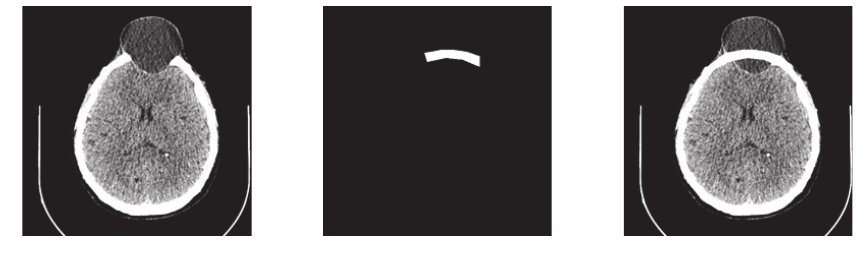
Figure 5. Fracture reconstruction using C 1 rational cubic Ball